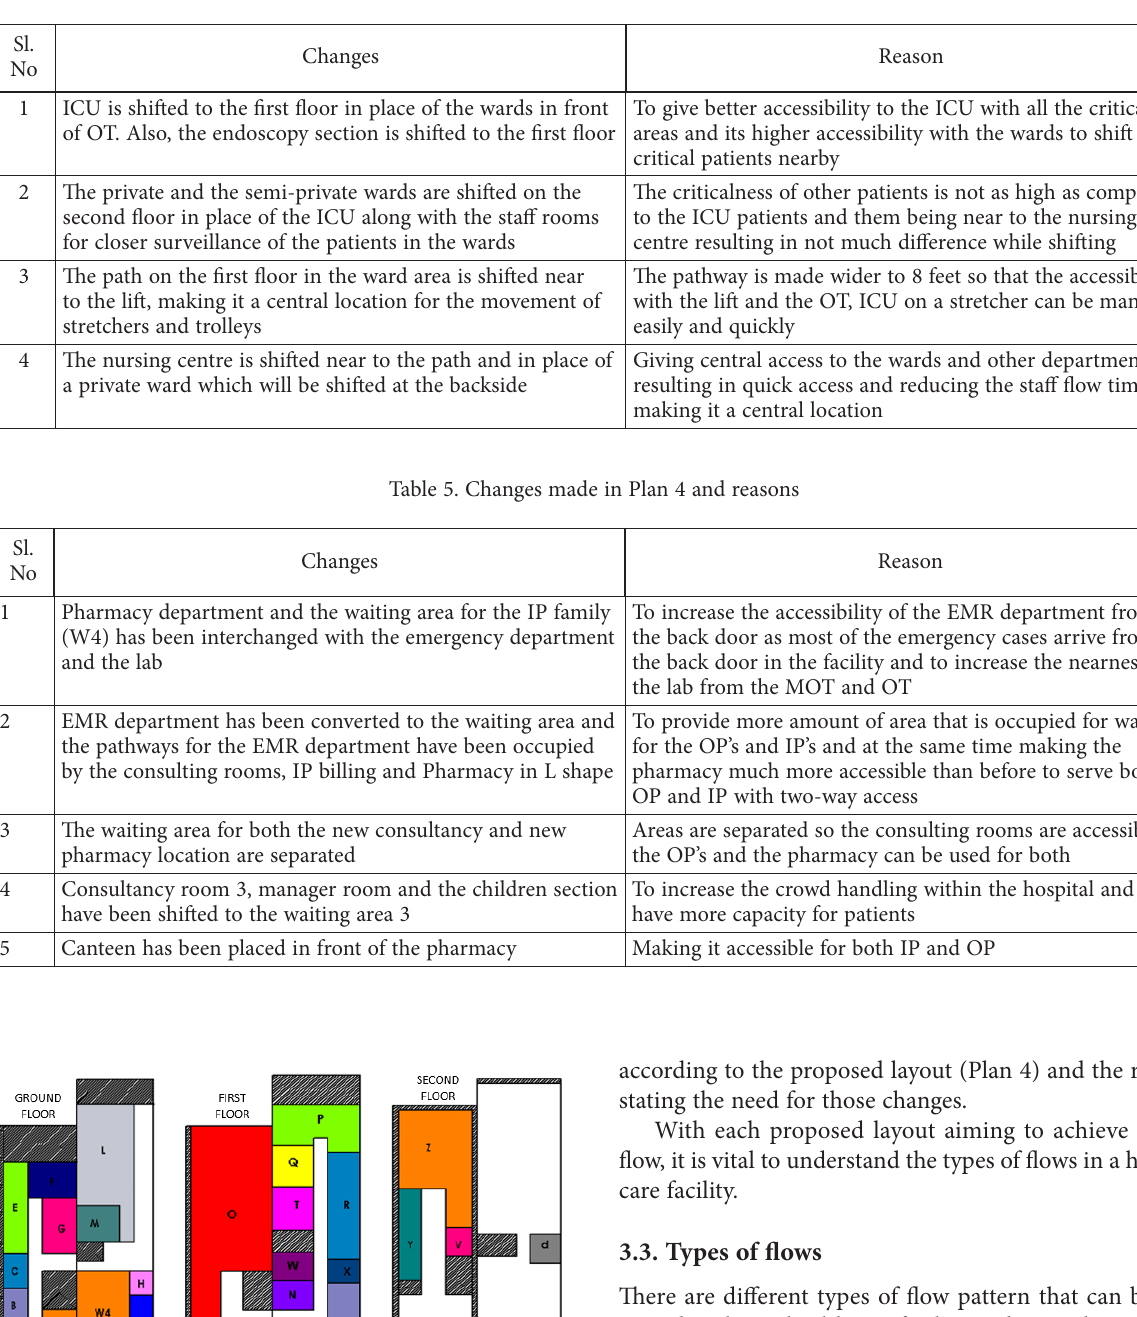
Table 4. Changes made in Plan 3 and reasons